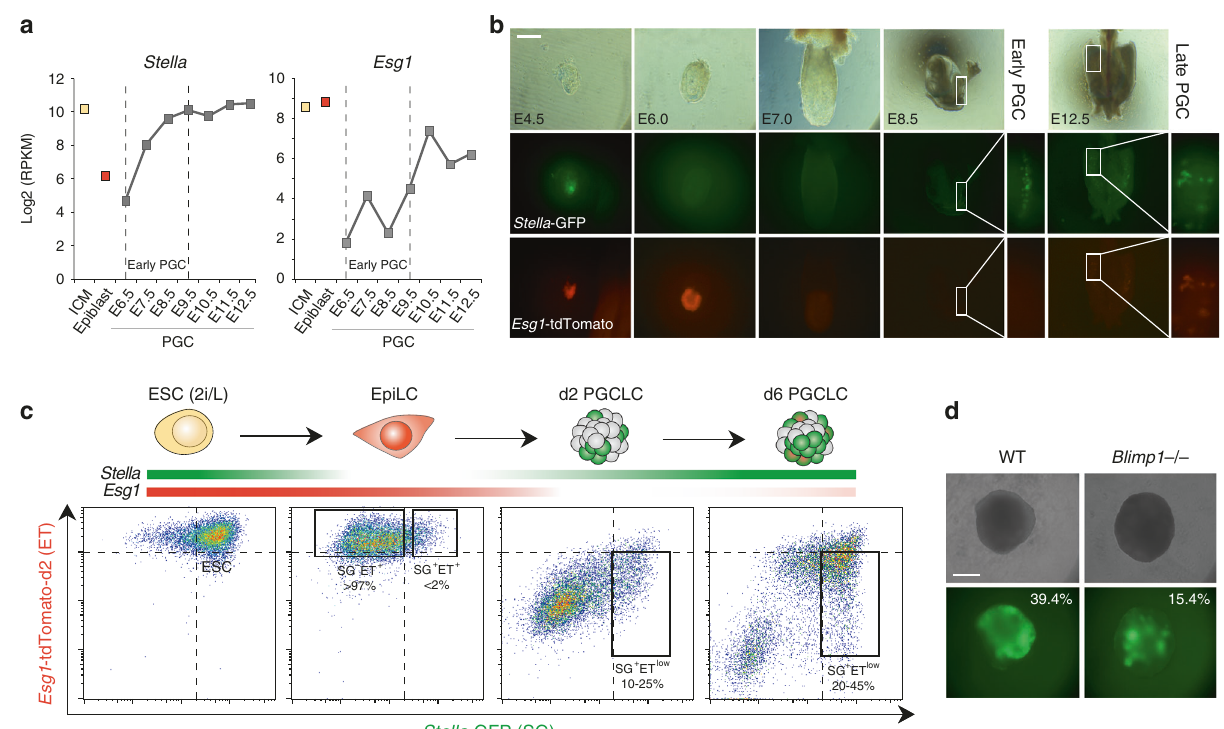
Fig. 1 The SGET reporter for tracking cell fate transitions toward PGCs. a Single-cell RNA-seq analysis showing reciprocal gene expression patterns of endogenous Stella and Esg1 during early development (ICM; E3.5 or Epiblast; E6.5) and in primordial germ cells (PGC). b Chimera and tetraploid complementation assays con fi rm faithful expression of the Stella- GFP (green) and Esg1- tdTomato (red) SGET reporter during early development and in PGCs. c Representative FACS analysis of SGET activation during in vitro cell fate transitions of ESC into EpiLC and subsequently PGCLC. d Representative images of impaired PGCLC induction from Blimp1 − / − SGET ESC. Numbers indicate percentage of SG + ET low PGCLC at day 5 as determined by FACS.